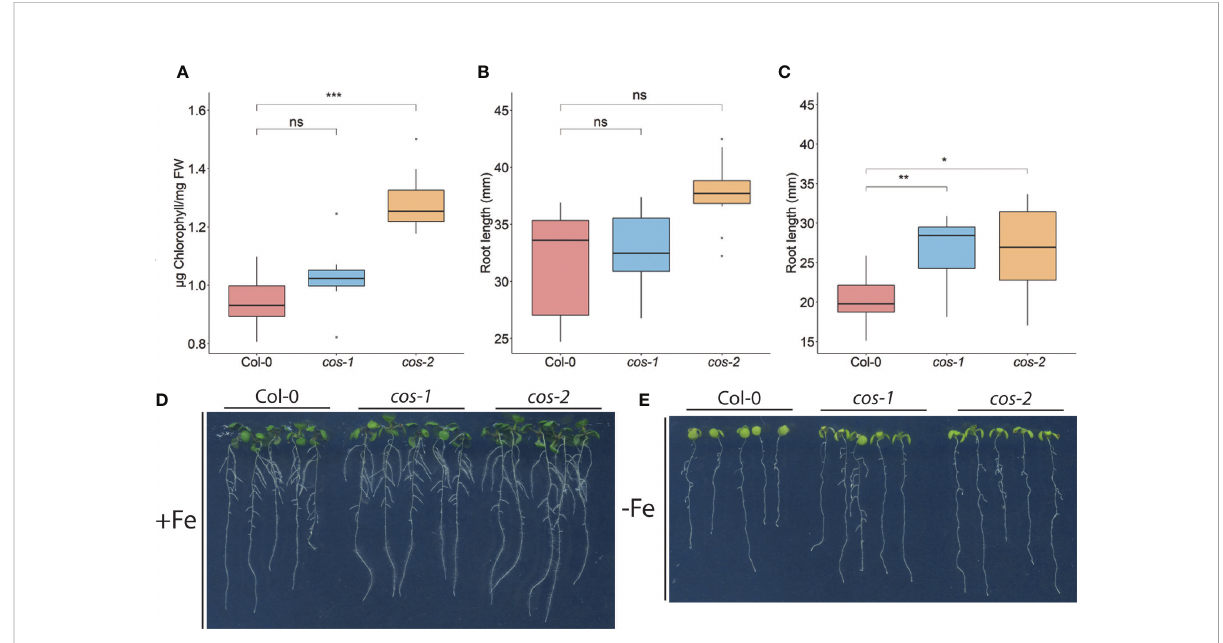
FIGURE 4 Phenotype of cos T-DNA mutants on 1/2X MS medium. (A) Total chlorophyll concentration of the shoot systems of plants grown on soil for 14 d. (B, C) Total root length of seedlings grown on 1/2X MS agar medium either with 50 m M Fe-EDTA (+Fe) or without Fe (-Fe) for 10 days. (D) Seedlings were grown on 1/2X MS agar medium either with 50 m M Fe-EDTA (+Fe) or without Fe (-Fe) for 10 days. * represents p-value ≤ 0.01, ** represents p-value ≤ 0.001, *** represents p-value ≤ 0.0001, ns, not signi fi